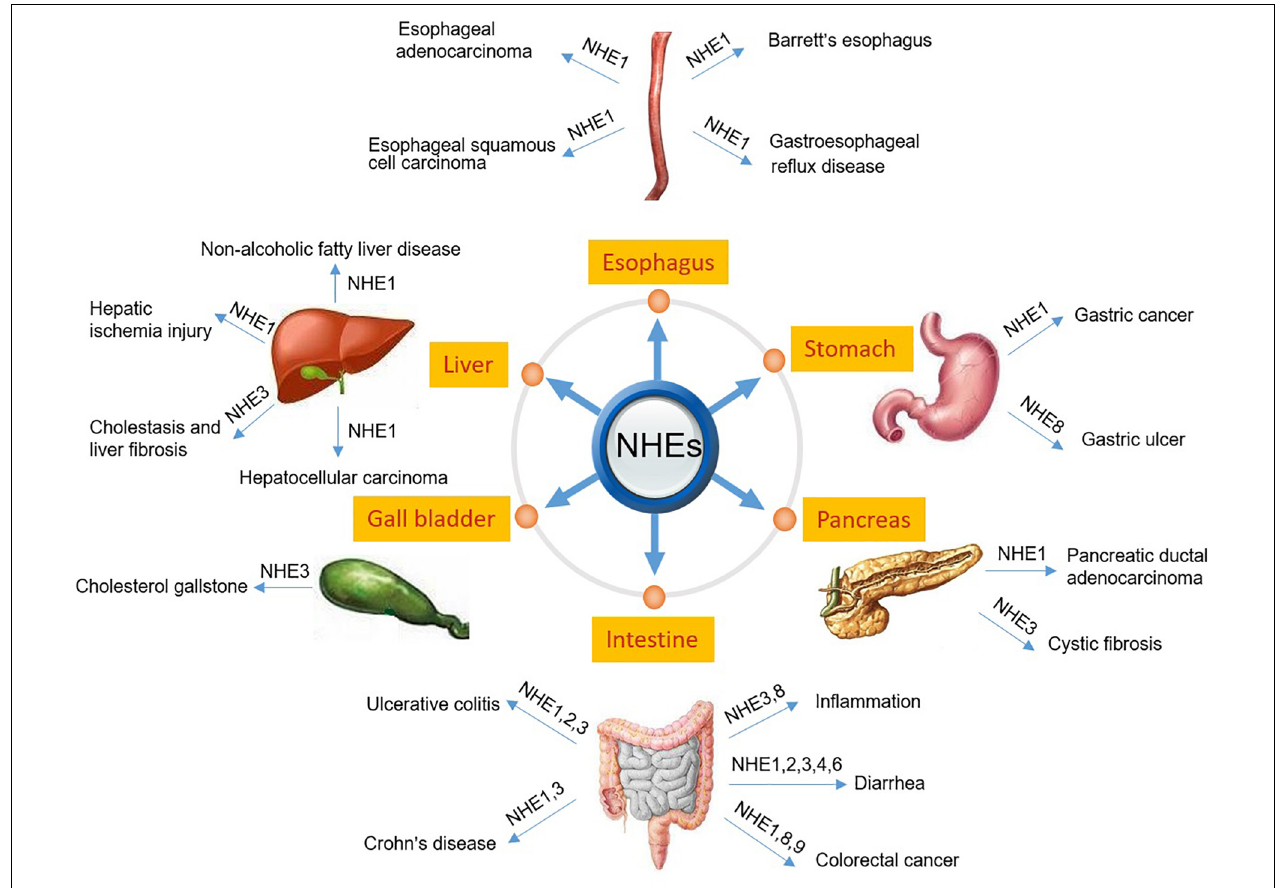
FIGURE 1 | Schematic diagram depicting NHEs that have been known to be related to the pathogenesis of digestive